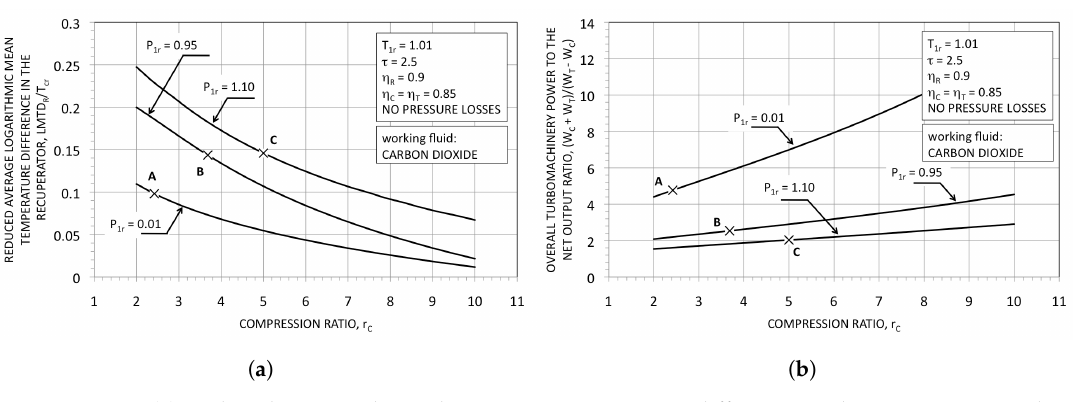
Figure 4. ( a ) Reduced average logarithmic mean temperature difference in the recuperator, and ( b ) turbomachinery power at different minimum reduced pressures as a function of the compression ratio. The minimum reduced temperature T 1, r and the temperature ratio τ are fixed.